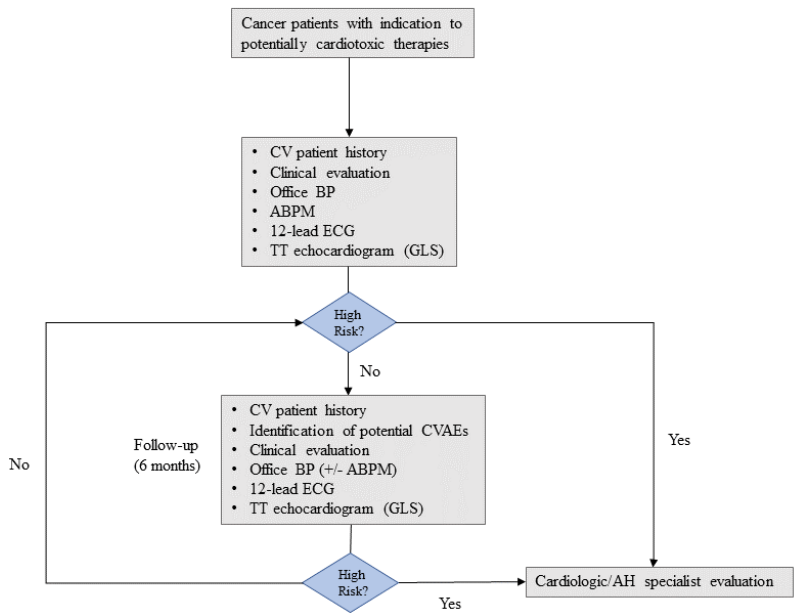
Figure 2. Protocol of patient selection and follow-up. CV: cardiovascular, BP: blood pressure, ABPM: ambulatory blood pressure monitoring, GLS: global longitudinal strain, CVAEs: cardiovascular adverse events; AH arterial hypertension, TT: transthoracic